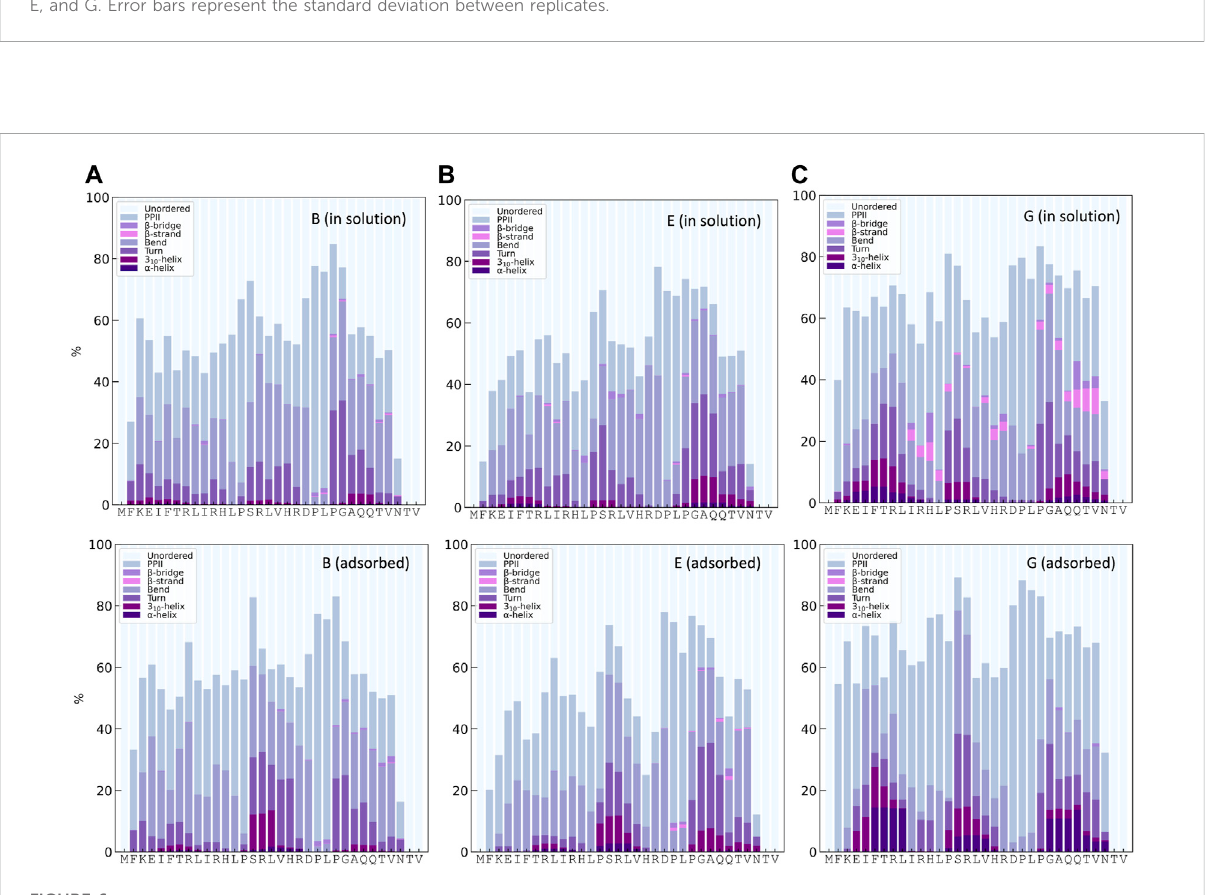
Secondary structure content along the sequence from DSSPPII analysis for KEIF in solution (top) and adsorbed (bottom) for the force fi eld andwater combinations B, E, and